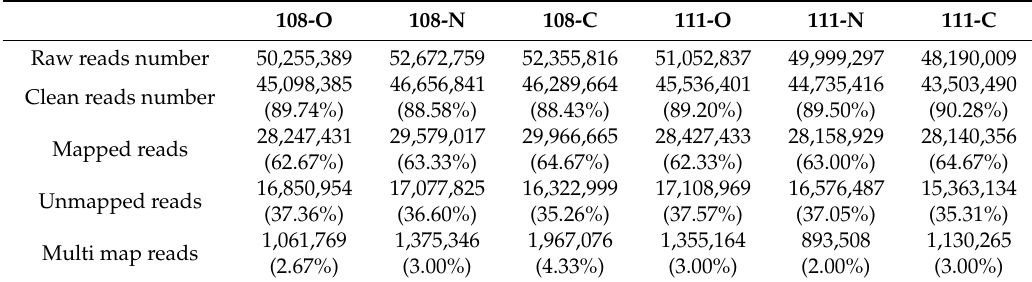
Table 1. Sequencing data and genome mapping analysis.